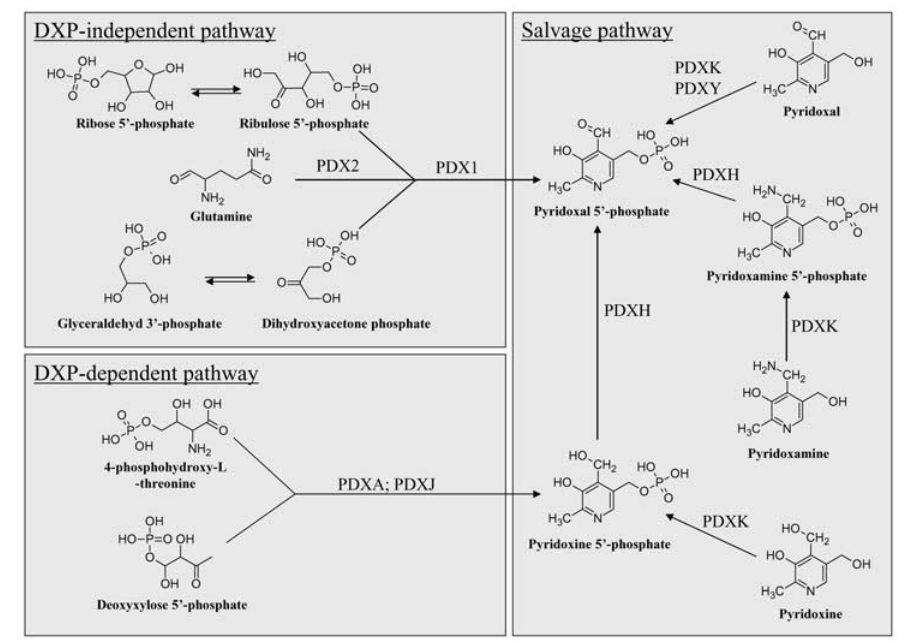
Figure 1 . Schematic drawing of de novo and salvage